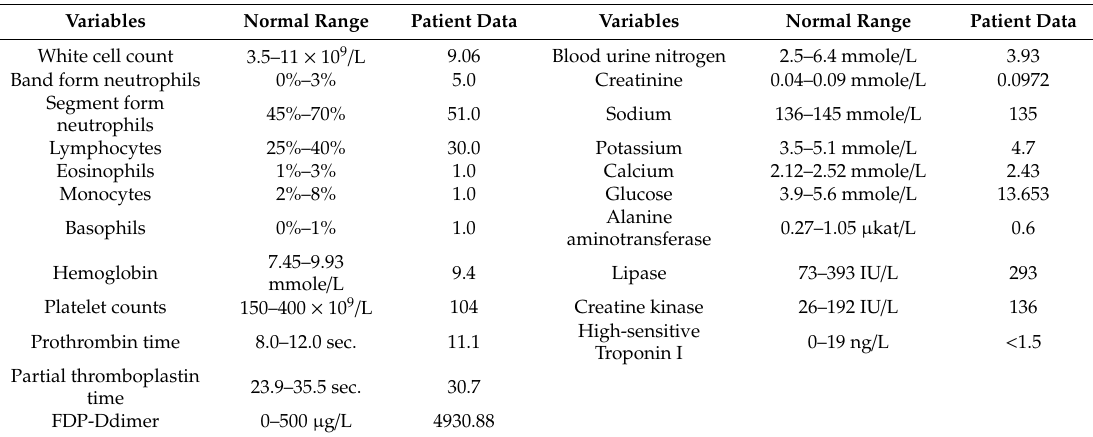
Table 1. The laboratory evaluation in this